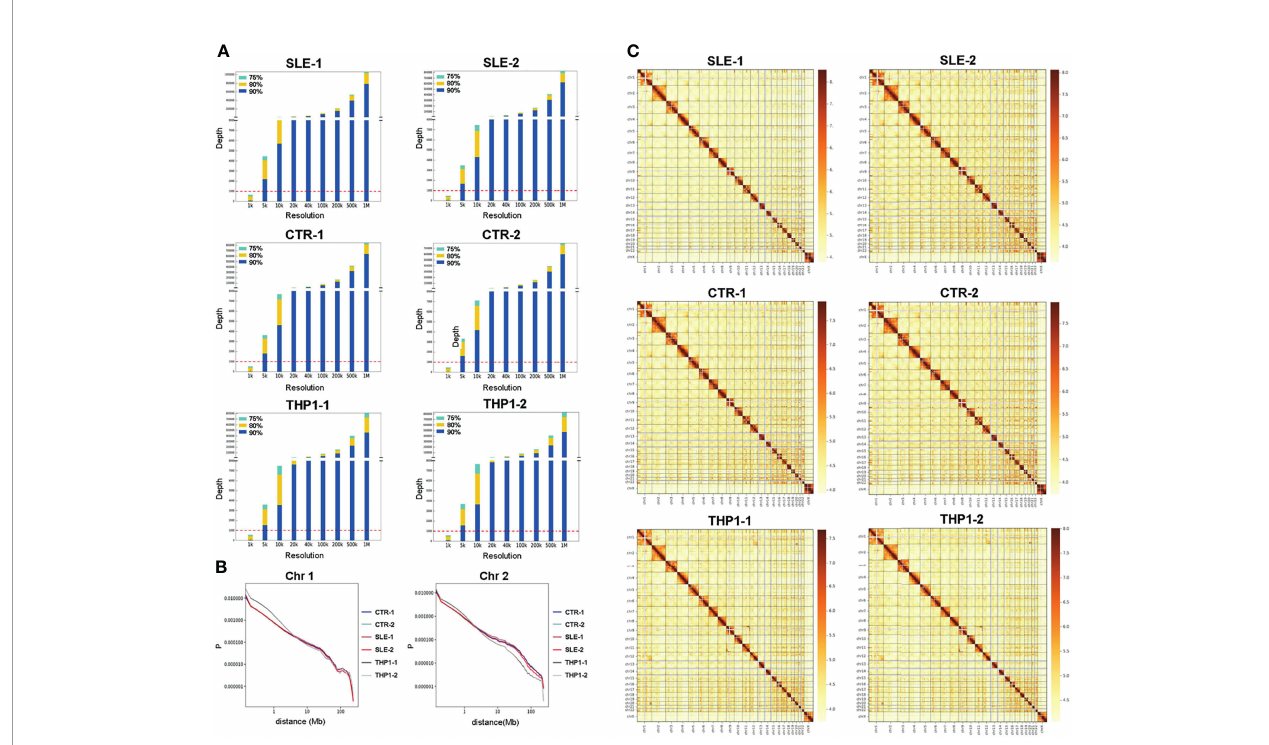
FIGURE 1 | Chromatin interaction map of monocyte. The summary of high-resolution chromatin interaction maps of monocyte, including four primary monocyte samples of SLE-1, SLE-2, CTR-1, CTR-2 and two repeats of THP1. (A) Resolution analysis of the Hi-C data from six samples, the horizontal axis indicates the bin size of resolution, the vertical axis indicates the depth of reads. (B) The relative contact probability (RCP) in chromosome 1 and chromosome 2. (C) The heatmap of genome-wide chromatin interaction in 1Mb bin, the colors present logarithmic transformed normalized interaction value, Both the cis- (within chromosome) and trans- (inter chromosome) interactions are